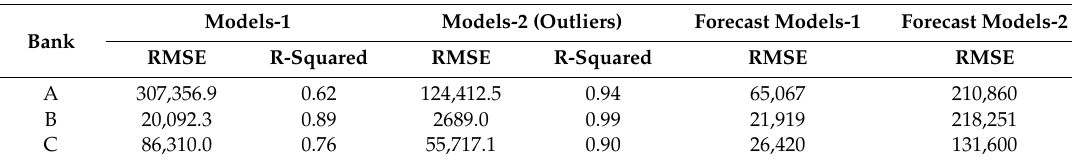
Table 5. Goodness of